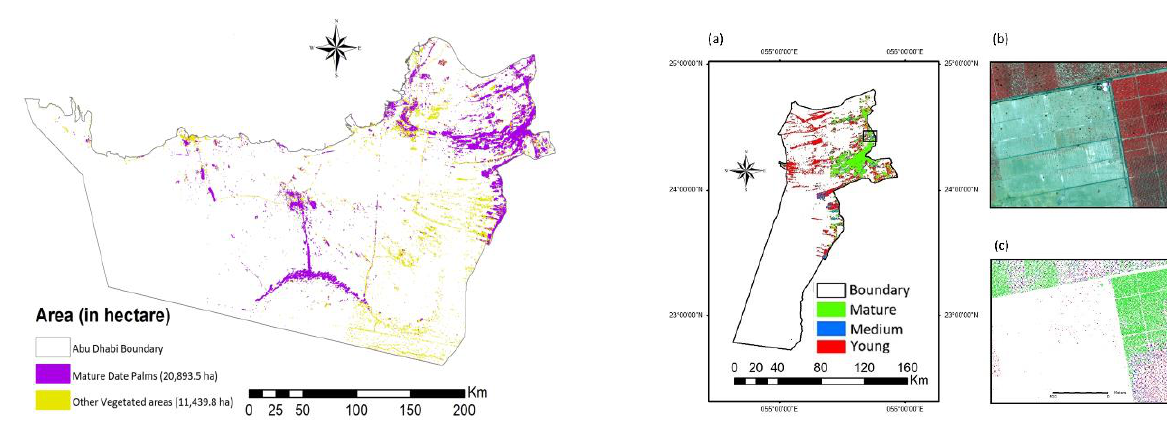
Figure 6. Map of Date Palms age classes at Eastern District,